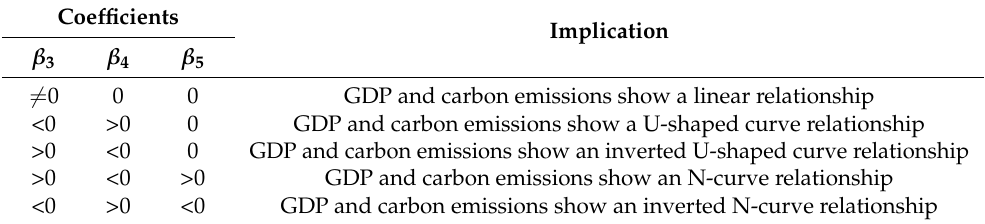
Table 1. Different relationships between GDP and carbon